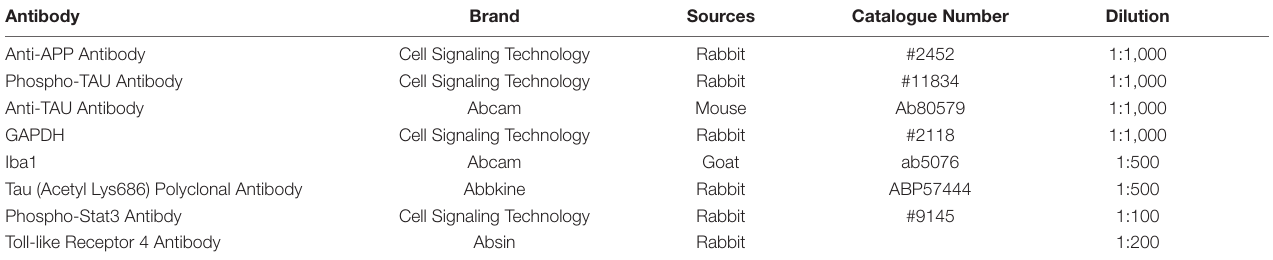
TABLE 1 | Details of the Antibodies used. Antibody